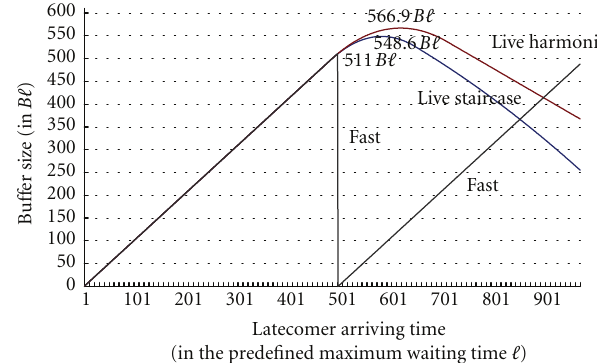
Figure 10: The relation between the bu ff er requirement and the client’s arrival time.